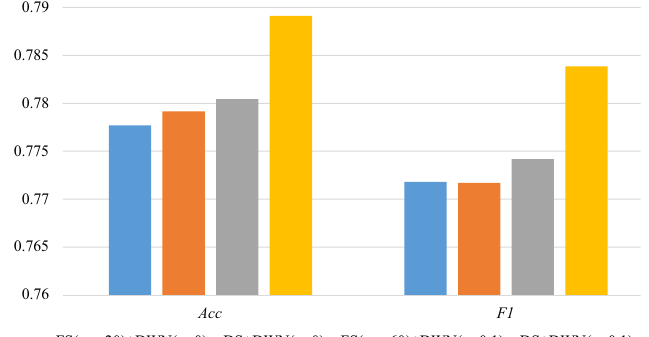
Figure 9. Comparison results of volatility and non-volatility, fixed and dynamic window